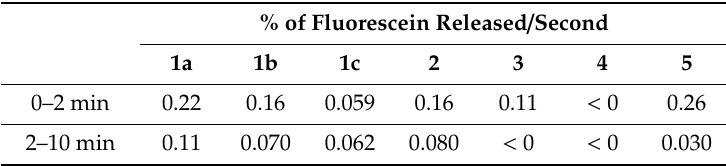
Table 2. Averaged payload photorelease rates during initial 0–2 min (upper row) and subsequent 2–10 min (lower